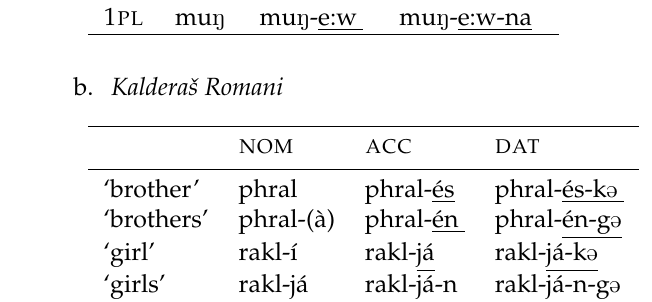
küsün turad 1 stands